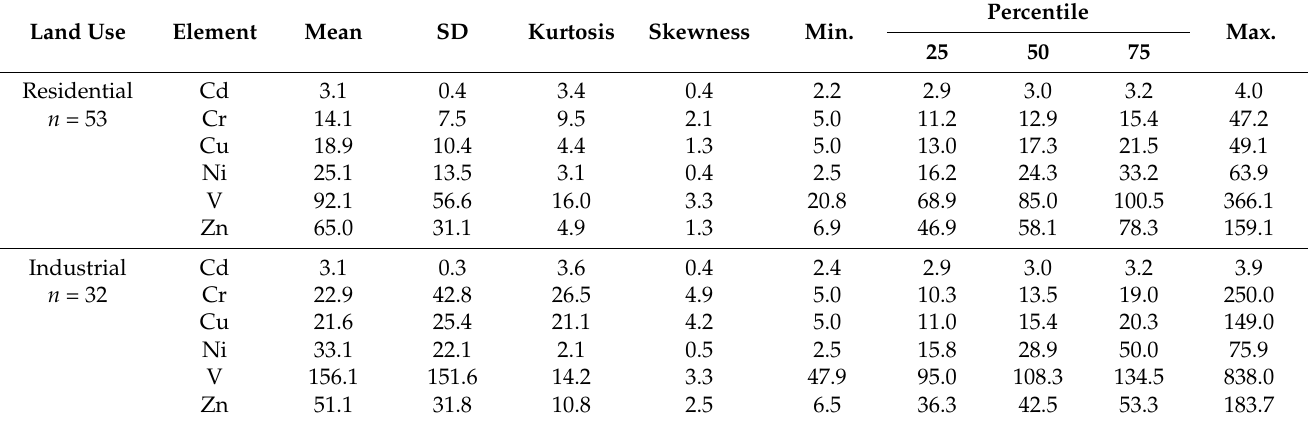
Table 3. Descriptive statistics of element concentrations by soil use.